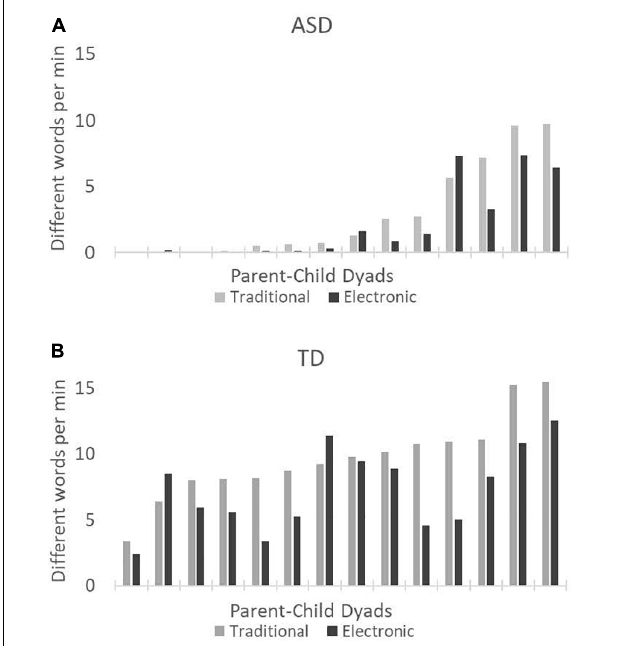
FIGURE 2 | Mean number of different (i.e., unique) words per minute produced by the children with autism spectrum disorder (ASD) (A) and the children with typical development (TD) (B) . Gray bars represent traditional toy play, and black bars represent the electronic toy play. Each pair of bars on the x -axis represents a single parent-child dyad. Data are presented left to right in order of increasing values for traditional toy